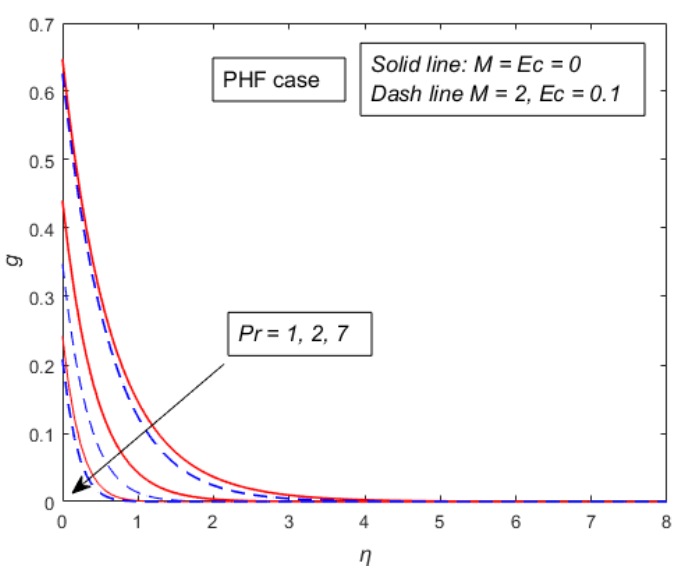
Figure 13. Variation of the temperature profile for different values of Prandtl number Pr , Eckert number Ec , and magnetic parameter M on the temperature profile for the PHF case when n = 3 and K =